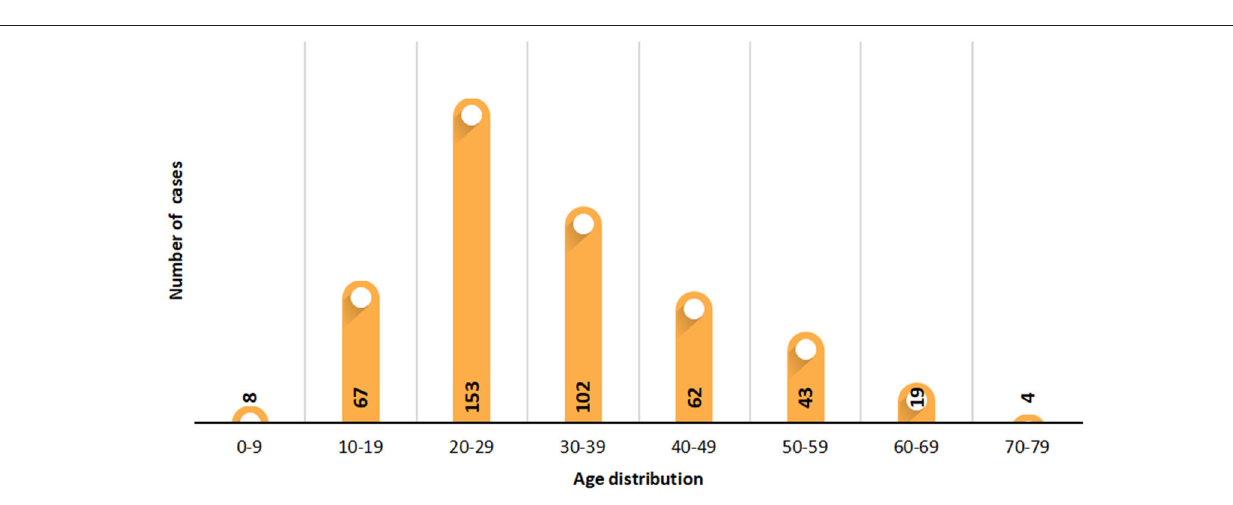
FIGURE 3 | Age distribution of imported cases from